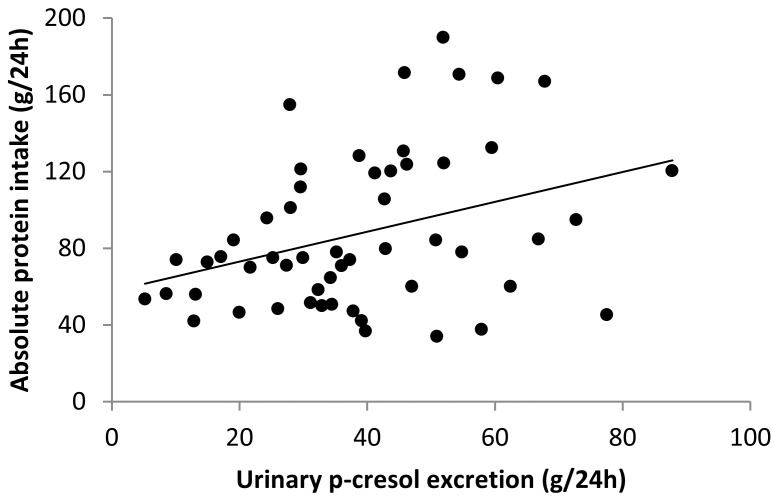
Scatter plot of the comparison between urinary p-cresol excretion (mg/24 h) and absolute protein intake (g/24 h).Urinary p-cresol excretion correlated positively with absolute protein intake (Spearman’s r = 0.371, p = 0.007).